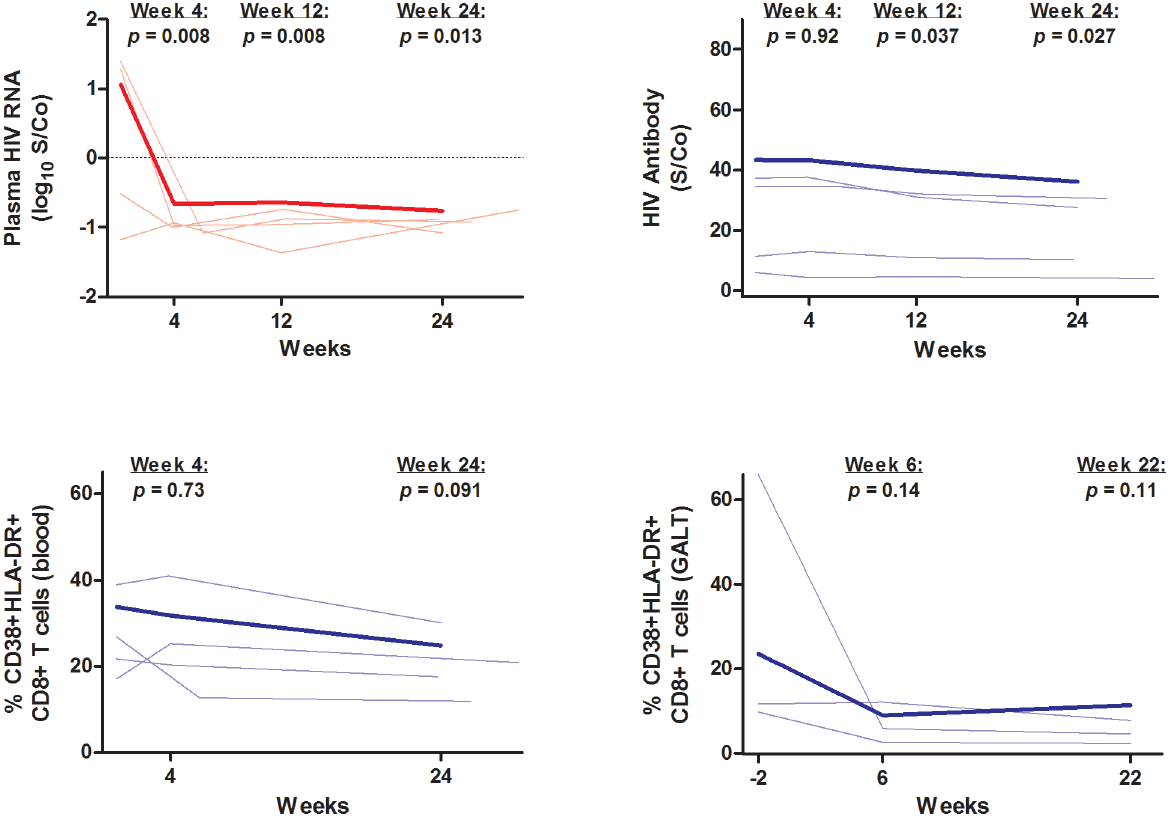
Figure 8. ‘‘Elite’’ controllers (n=4). Change in ultrasensitive plasma HIV RNA, HIV antibody levels, and T cell activation in peripheral blood and rectum in 4/16 controllers with baseline plasma HIV RNA , 40 copies/mL. Thin lines indicate data for each individual subject (n=4). The thick line indicates the estimated mean value over time from mixed effects linear regression for the entire cohort (n=16). The y-axes are on the same scale as Figures 2, 5, and 6. P-values refer to change from baseline at each referenced time-point. S/Co=signal/cutoff ratio. GALT=gut-associated lymphoid tissue.